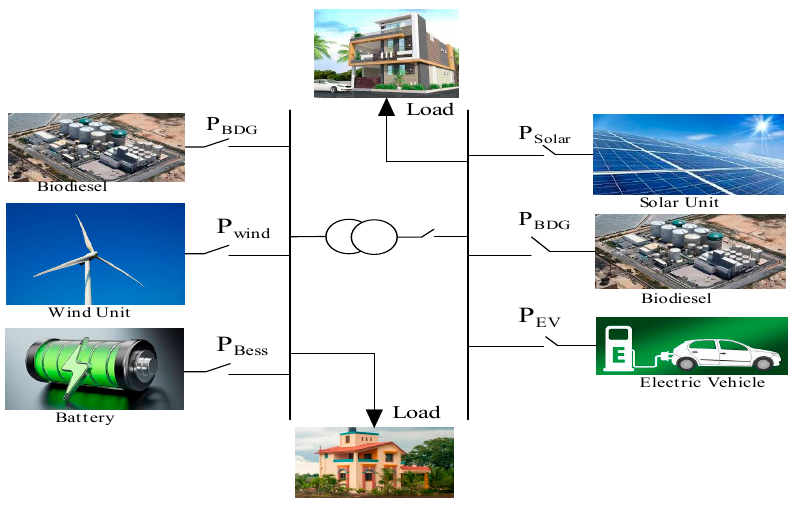
Figure 3. Schematic diagram of microgrid .